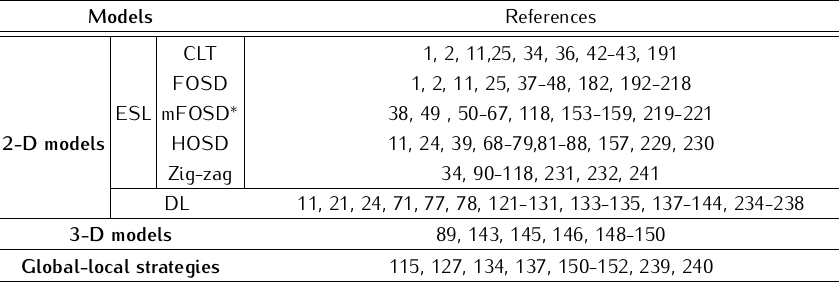
Table 1. General classification of macro-mechanical models for multi-layered